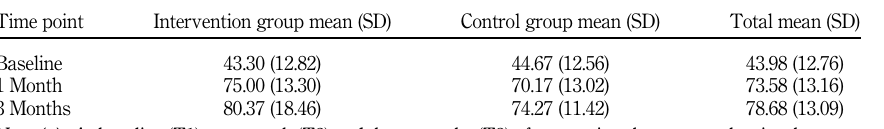
Table 2. Comparison of